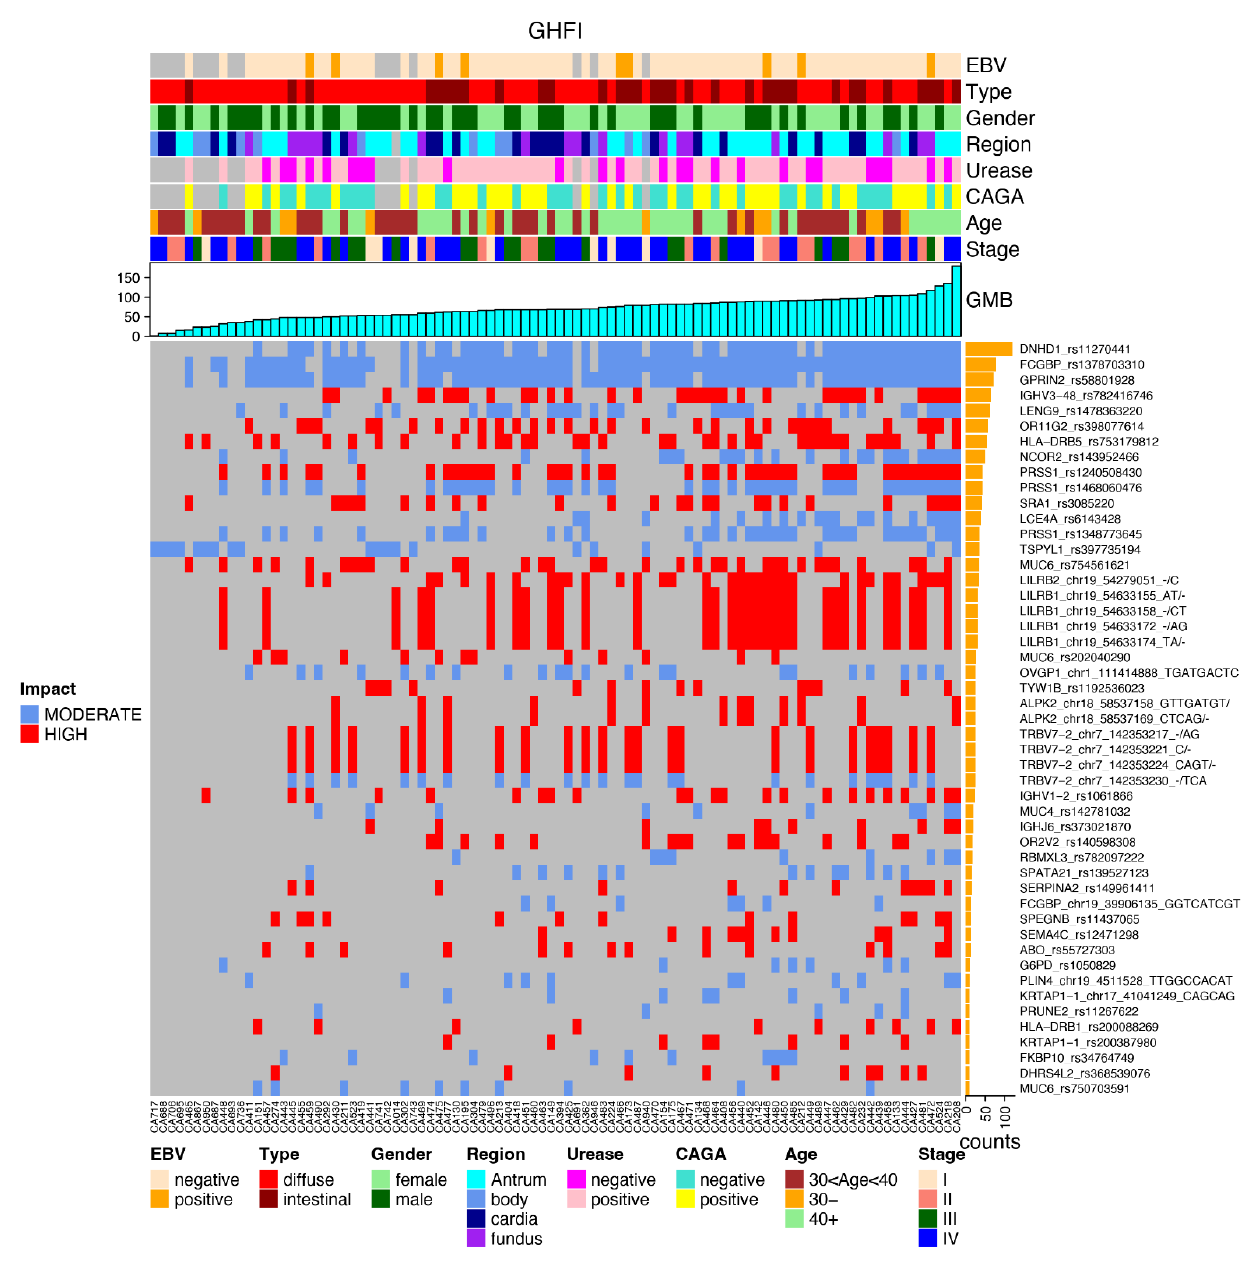
Figure 5. Correlation of most prevalent variants in the GHFI gene’s subset among young patients with gastric cancer and their distribution according to clinical features (EBV status, histological type, gender, region of the stomach, urease status, CAGA status, age group and stage), GMB and mutation impact (moderate or